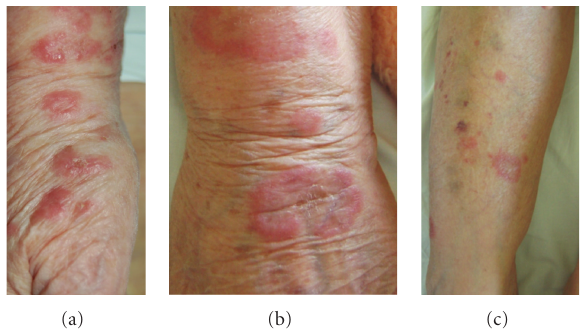
Figure 1: Chronic periaortitis presenting as recurrent cutaneous eosinophilic vasculitis (RCEV). (a, b) Urticarial, partly annular skin lesions of dorsal and medial aspects of right wrist-hand region. (c) Urticarial-erythematous skin lesions of the right leg; note signs of blood extravasations in healed lesions.